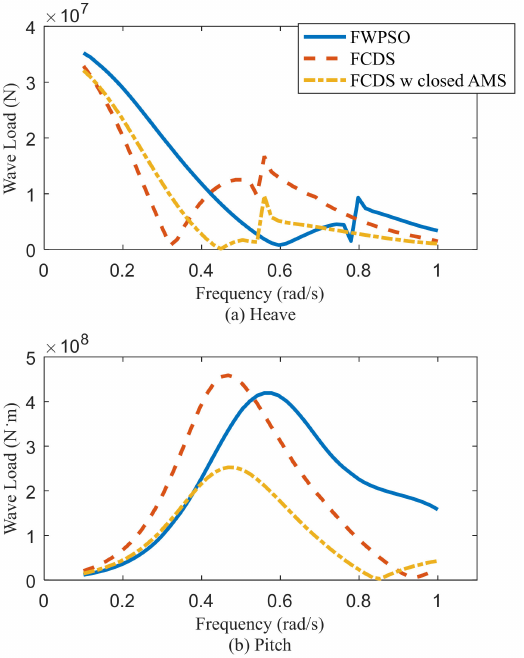
Figure 6. First-order wave load transfer functions of the heave and pitch.